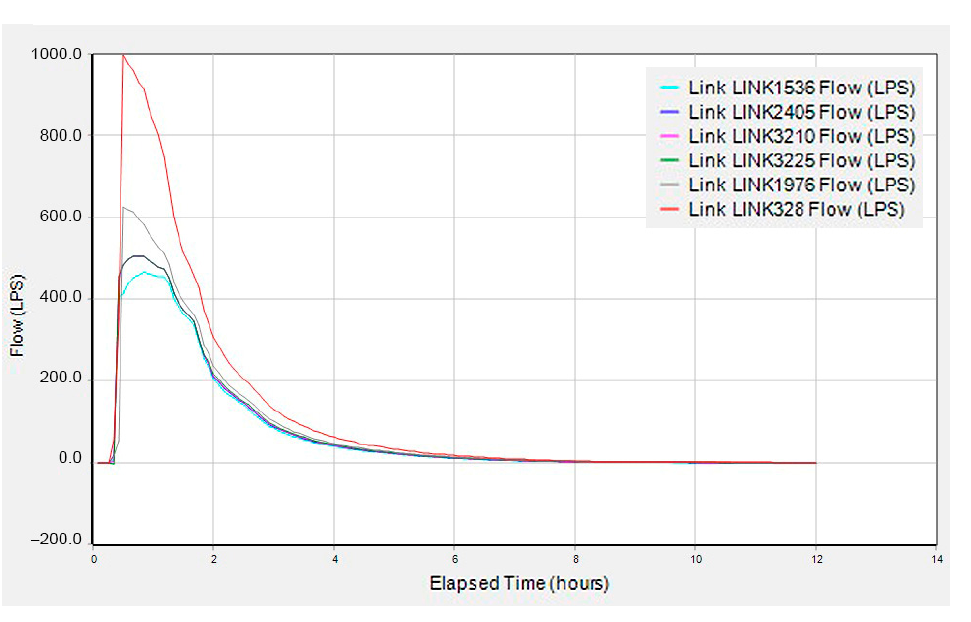
Figure 6. Flow hydrograph: TR = 25 years, Via XXIV Maggio.